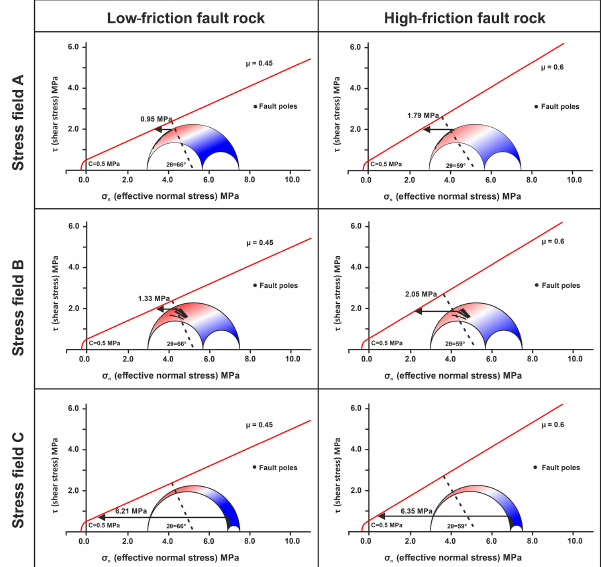
Figure 7. Mohr diagrams illustrating the fracture stability for the Coyote Wash Fault within the three stress fields for two types of fault rocks. Black arrows indicate the increase in pore pressure needed to force the fault into failure. Number of fault poles in each plot is 3525.